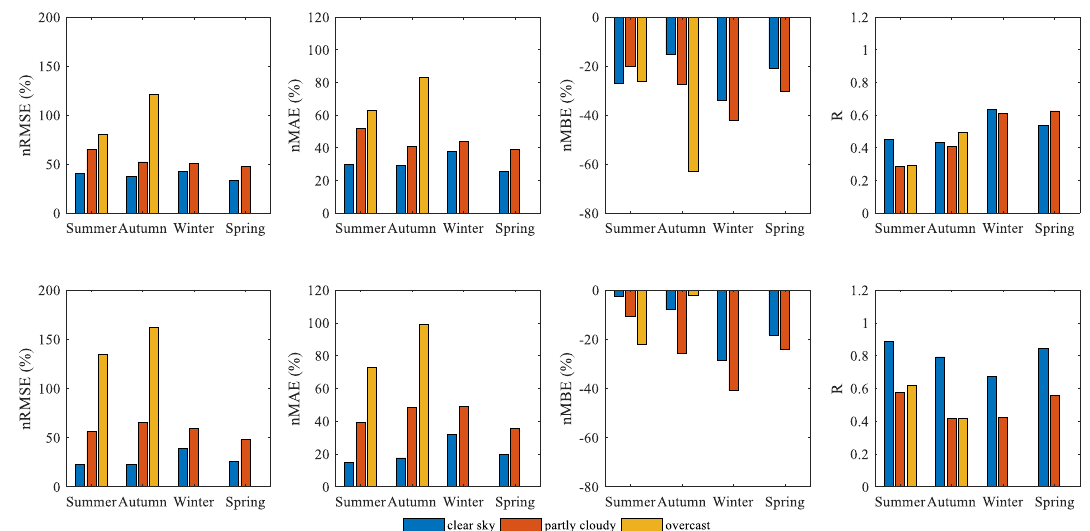
Figure 6. Monthly trend chart of the estimated DNI.